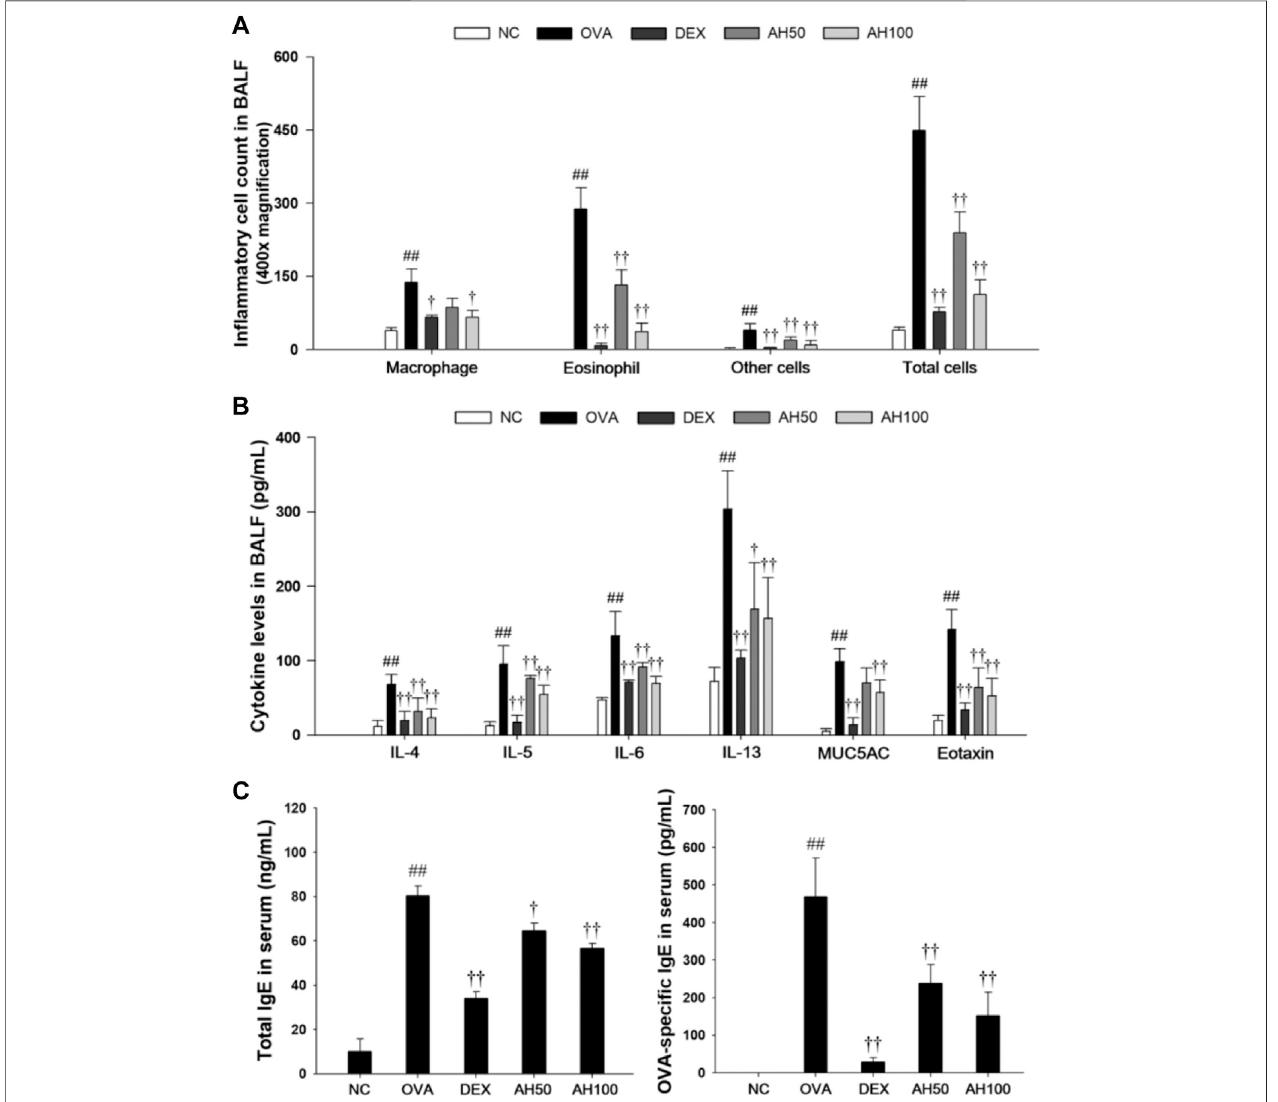
FIGURE 3 | AH reduces in fl ammatory cell number, in fl ammatory cytokines, eotaxin, MUC5AC, total IgE and OVA-speci fi c IgE in bronchoalveolar lavage fl uid or serum of mice 48 h after fi nal OVA challenge. (A) The in fl ammatory cells were attached on slide and stained with Diff-Quik stain reagent. (B) The levels of IL-4, IL-5, IL-6, IL-13, eotaxin and MUC5AC in the BALF were determined by ELISA. (C) Total IgE and OVA-speci fi c IgE were determined using ELISA. NC: normal control mice; OVA: OVA-challenged mice; DEX: dexamethasone (3 mg/kg) + OVA-challenged mice; AH: AH (50 or 100 mg/kg) + OVA-challenged mice. The values are expressed as the means ± SD (n (cid:2) 7/group). ## p < 0.01, signi fi cantly different from NC group; †† p < 0.01, signi fi cantly different from OVA-challenged